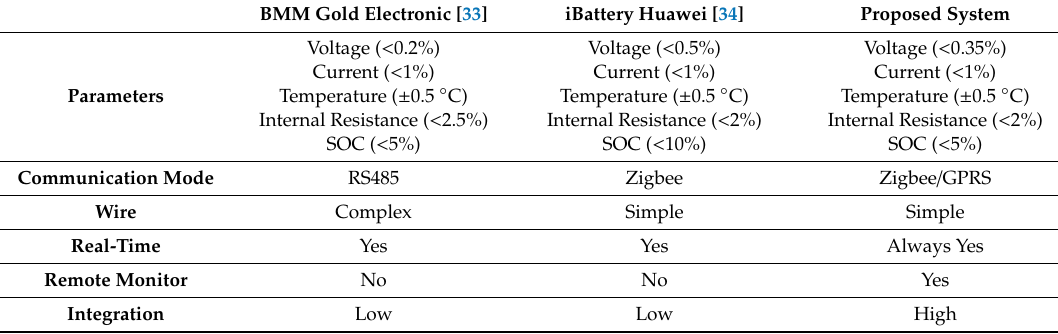
Table 2. Comparison of proposed system with existing devices.